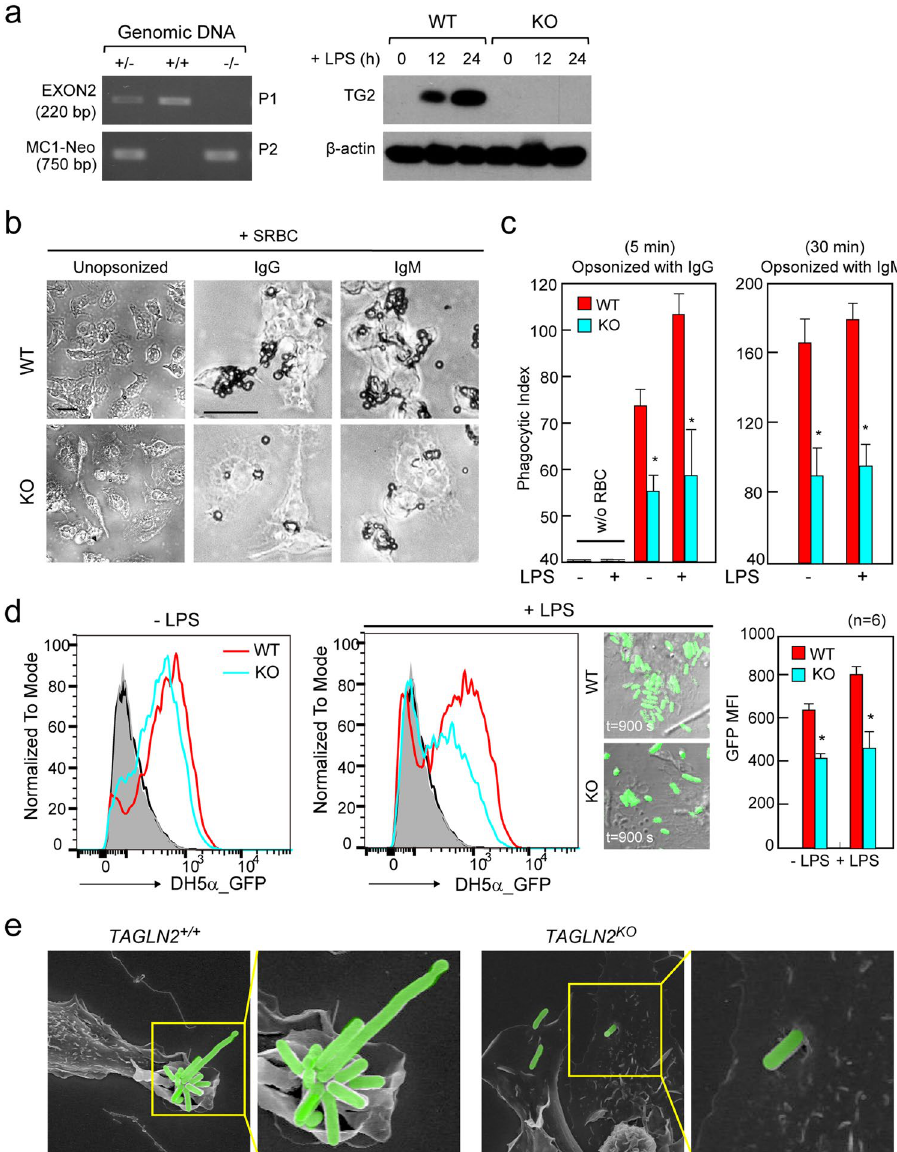
Figure 2. Defective phagocytosis in macrophages from TAGLN2 − / − mice. ( a ) PCR genotyping. Genomic DNA was extracted from mouse ear tissue. The wild-type ( + / + ) and heterozygote mutant ( + / − ) alleles were detected with primer (P1) targeting EXON2, whereas the homozygote ( − / − ) alleles were not detected with this primer. Using the P2 (MC1-Neo) primer set, the heterozygote and homozygote alleles, but not the wild-type allele, were detected. TAGLN2 protein in macrophages from wild-type and TAGLN2 − / − mice was determined by Western blot analysis. Isolated cells were stimulated with LPS (1 μ g/mL) for 12–24 h. Results are representative of three independent experiments. ( b and c ) Impaired Fc γ R- or CR-mediated phagocytosis in TAGLN2 − / − macrophages. Full-length blots/gels are presented in Supplementary Fig. S8. ( b ) Peritoneal macrophages from wild-type and TAGLN2 − / − mice were activated with LPS (1 μ g/mL) for 24 h, incubated with IgG- or IgM-opsonized sRBC, fixed, and imaged at various time points (IgG, 5 min; IgM, 30 min). Scale bars, 5 μ m. ( c ) The phagocytic index was calculated as the number of internalized sRBC in 100 macrophages. * P < 0.05 vs . wild-type macrophages. ( d ) Phagocytic activity in vivo . GFP-expressing E. coli was injected into the peritoneum of recipient wild-type and TAGLN2 − / − mice. The phagocytic function was calculated by flow cytometry as the percentage of GFP- positive in F4/80-APC-gated cells. * P < 0.05, n = 10. Phagocytosis of GFP-expressing E. coli in wild-type and TAGLN2 − / − macrophages stimulated with or without LPS for 24 h. Time-lapse imaging of in vitro phagocytosis of GFP-expressing E. coli was performed with confocal microscopy (FV1000). Selected last still images from time-lapse movies (see Supplementary Videos S3–S4) are shown (t = 900 s). The imaging was started after the addition of GFP-expressing E. coli . Scale bars, 5 μ m. Quantification of phagocytosed E. coli cells by macrophages was represented as bar graph. * P < 0.05, n = 6. ( e ) Macrophages from ( d ) were exposed to the E. coli for 10 min, fixed, and processed for SEM. Scale bars, 5 μ m. Green fluorescence in the figure was